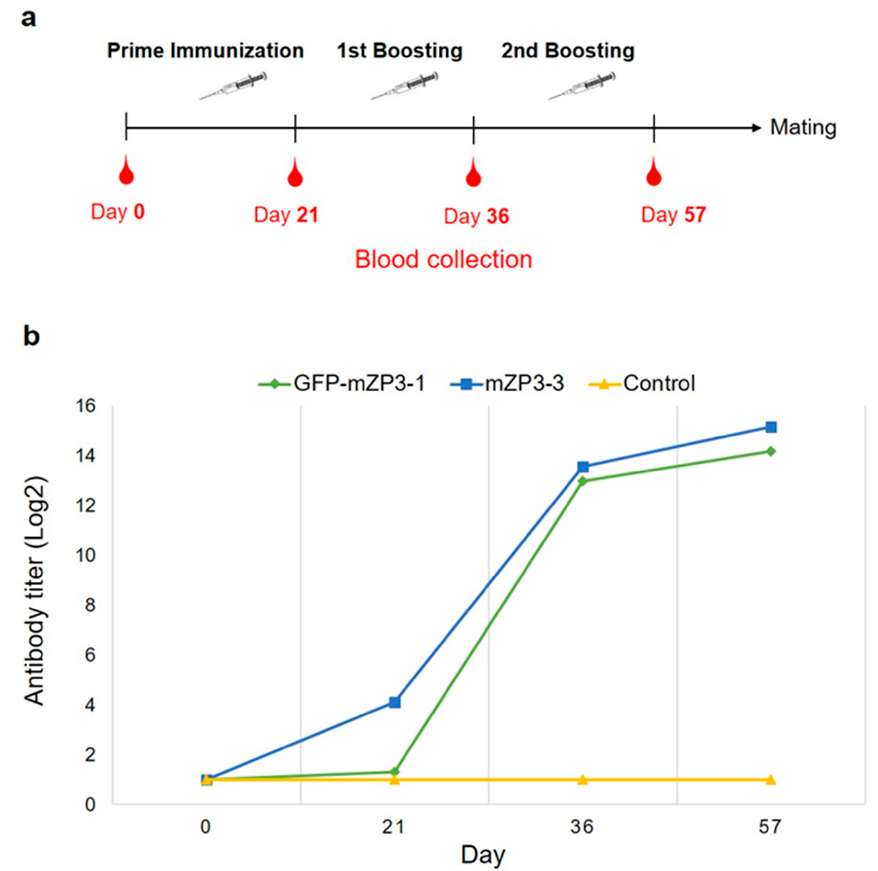
Figure 6. Kinetics of serum antibody responses in female BALB/c mice following prime-boost parenteral immunization. The mice were separated into three groups; two experimental groups were immunized with 50 µ g of ZP3 peptide, in the form of GFP-mZP3-1 or mZP3-3, along with Polygen adjuvant, and the Control group was immunized with PBS adjuvanted by Polygen. ( a ) Schematic representation of the immunization protocol and blood collection. ( b ) The endpoint titers of anti-mZP3 antibodies in BALB/c mice immunized with plant-produced GFP-mZP3-1 ( ♦ ), mZP3-3 ( ■ ), or PBS as a control ( ▲ ) on days 0, 21, 36, and 57. The values are the means log2 endpoint titers of all mice in each group ( N = 5).